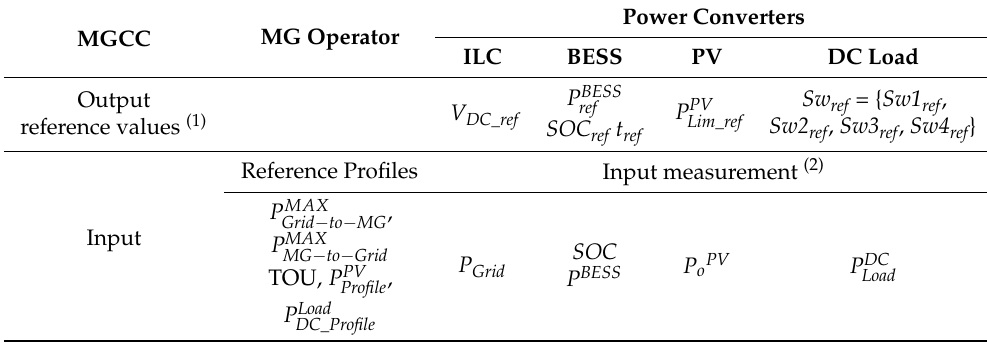
Table 5. Parameters broadcasted between the power converters of the DC microgrid and the MGCC.